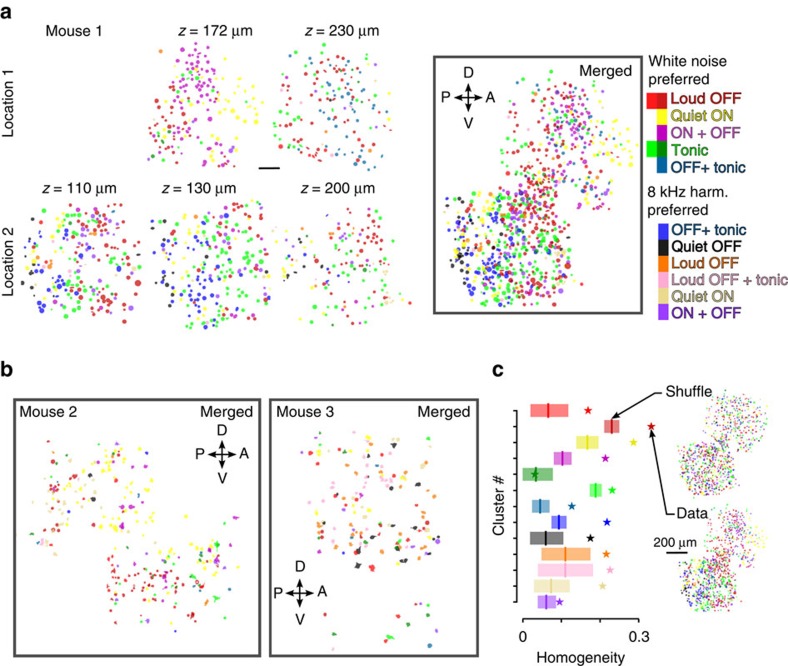
Functional cell types correspond to cell assemblies clustered in space.(a) Localizations of the cells belonging to the different identified clusters, colour-coded as in Fig. 4 (see colour bar on the right), in five imaging sessions performed at two different horizontal localizations and different depths (z) across several days in mouse 1. On the right, the relative localization of all cells is shown in a horizontally mapped z projection. Scale bar, 100 μm. (b) Horizontally mapped z projection for mouse 2 and mouse 3 (four imaging sessions each, Supplementary Fig. 4). (c) Each star represents the value of a homogeneity index calculated across three mice for each of the 13 clusters (same colour code as in a). The vertical lines represent the value expected if each cluster was homogenously spread in space obtained by shuffling and the shaded area is the 95% confidence interval. Maps obtained before and after shuffling are shown for one example mouse: note that cell shufflings are operated within individual mice, but homogeneity indexes averaged over neurons across all mice.